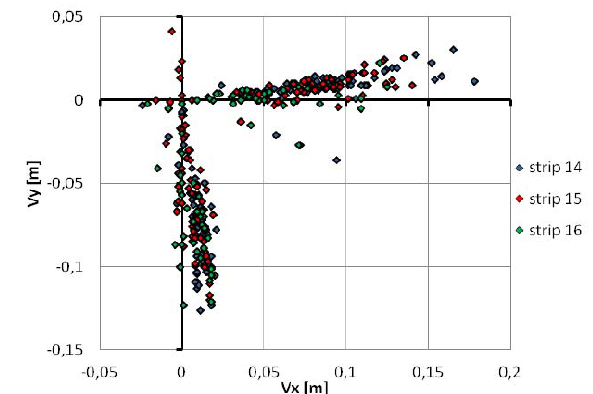
Figure 5. Measurements of plannimetric errors of roof ridges for all 3 LIDAR strip.